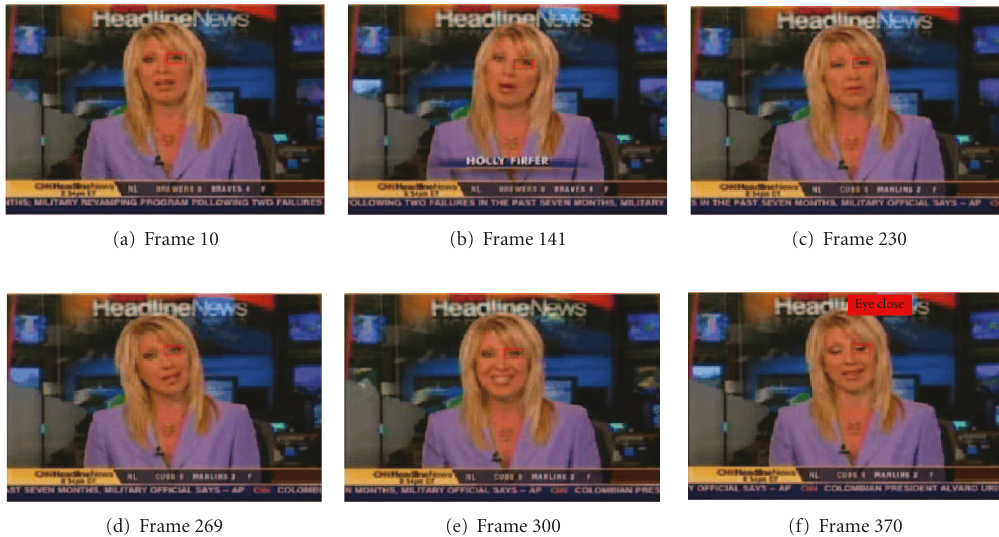
Figure 6: Examples of the blink detection results for news report videos. Red boxes are tracked eyes, and the blue dots are the center of the eye locations. The red bar on the top-left indicates the presence of closed eyes.